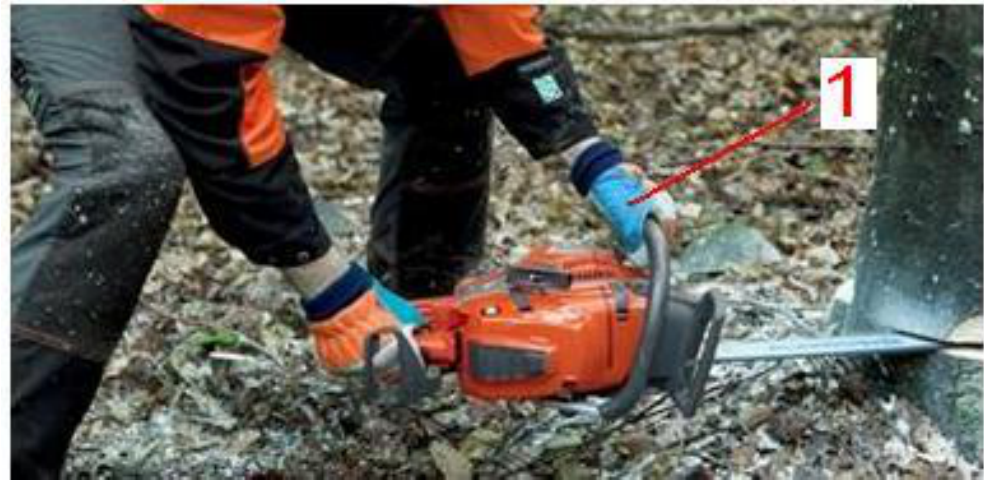
Figure 11. Sample position of a chainsaw operator during tree harvesting. 1: operator’s hand holding the front handle of the chainsaw in a position which prevents movement of the front guard (brake activation).